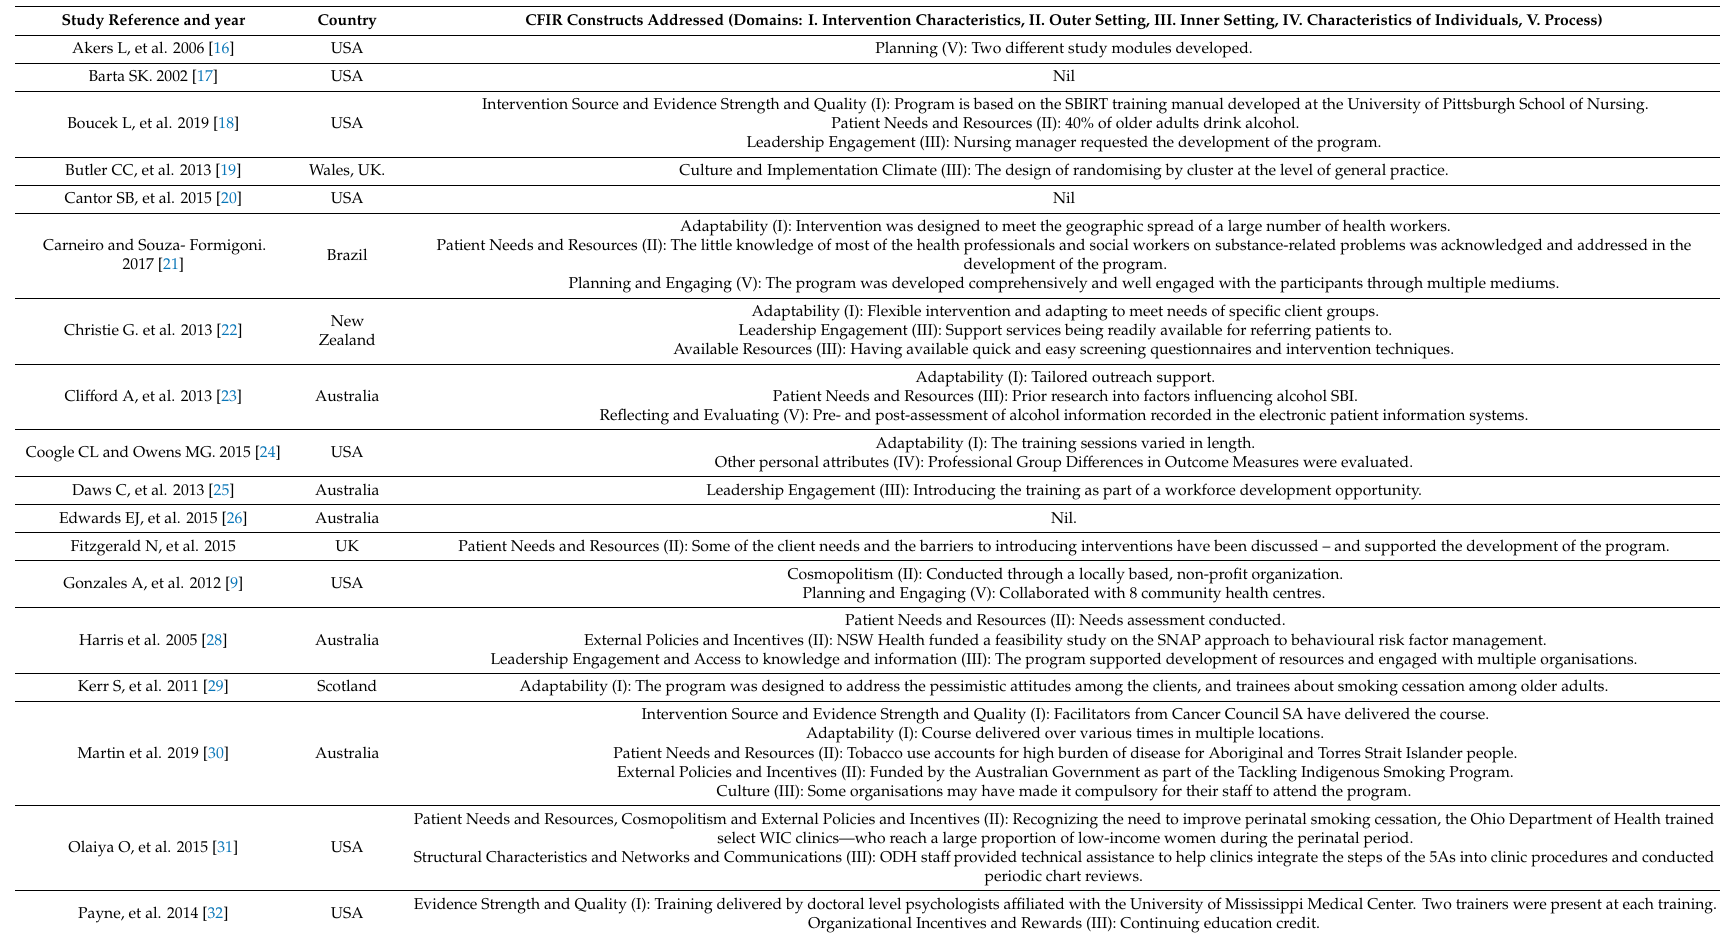
Table 3. Detailed references of CFIR Domains and Constructs in the reviewed